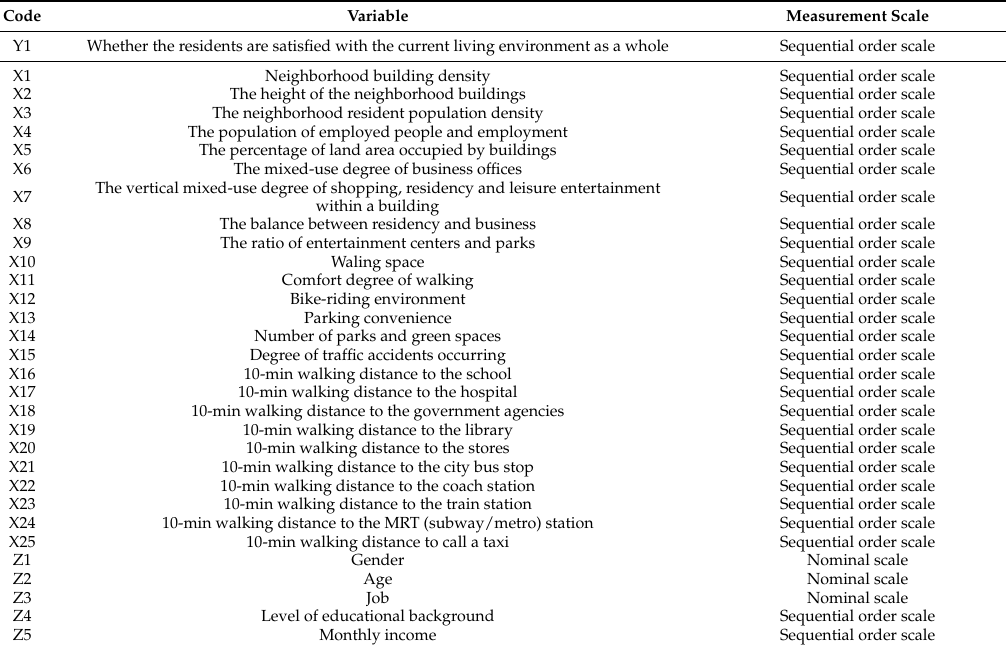
Table 1. Variables for TOD environment characteristics. MRT, mass rapid